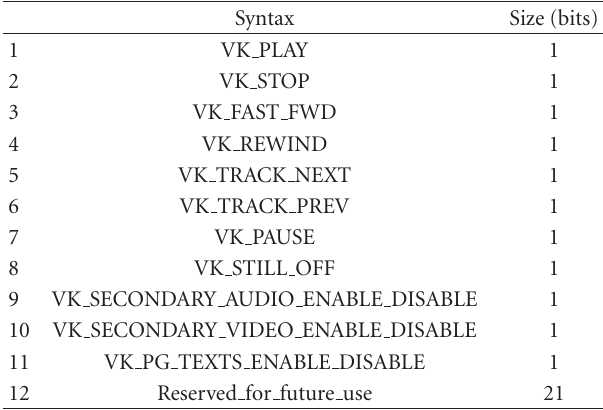
Table 8: Key interest